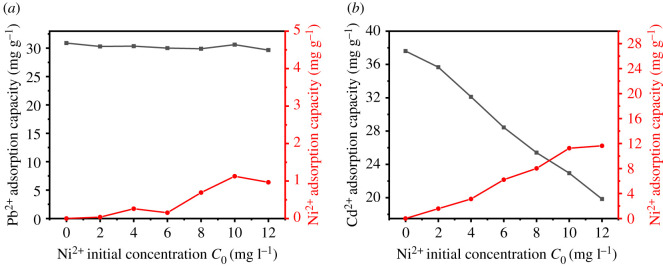
The influence of Ni2+ concentration on the adsorption of Pb2+ and Cd2+.